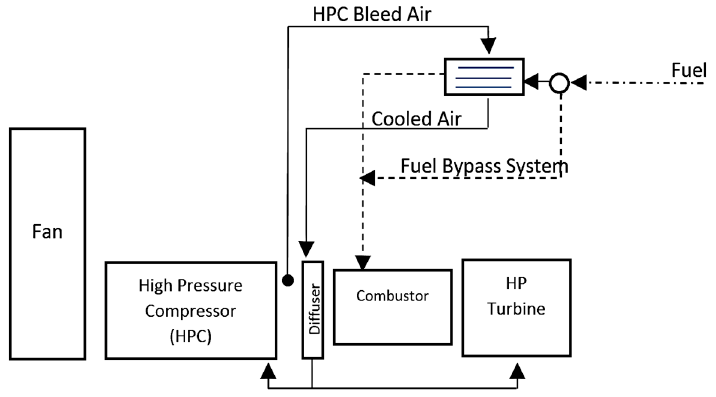
Figure 2. CCA concept using a Fuel-to-Air Heat Exchanger Concept.